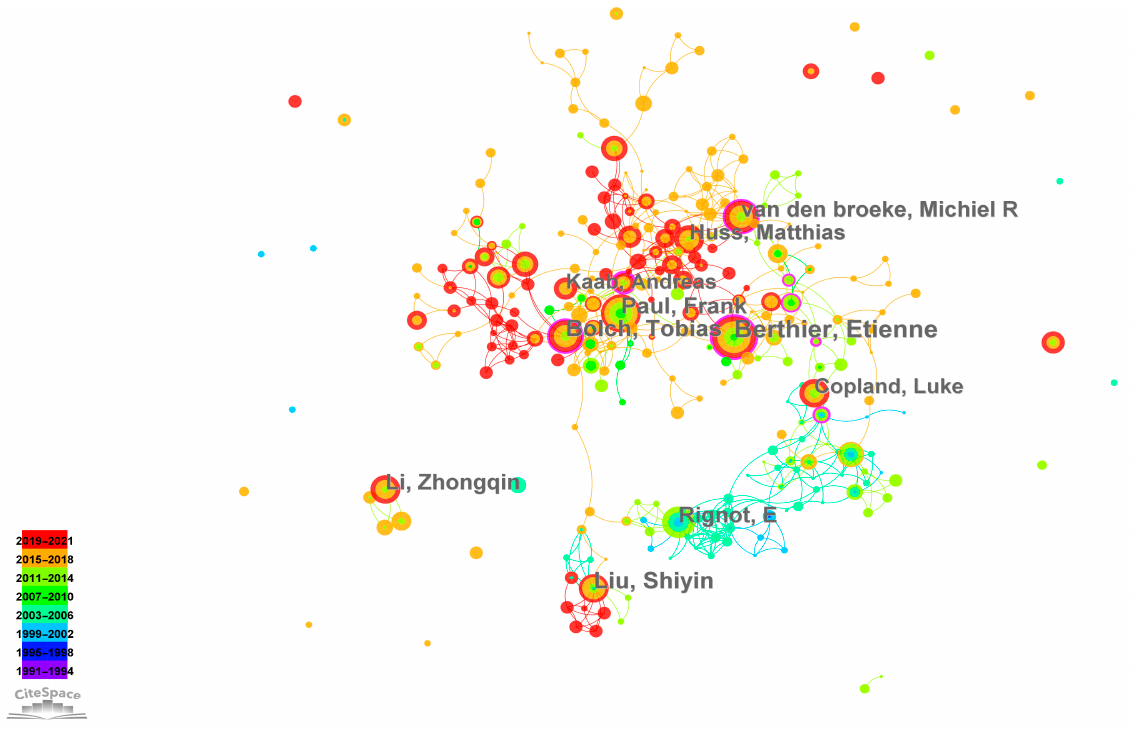
Figure 3. Knowledge map of author collaboration. Each node on the map symbolizes a different author, and the more articles they have produced, the larger the node. The connections between the nodes represent the collaboration between authors, and the thicker the line, the closer the collaboration [55] .